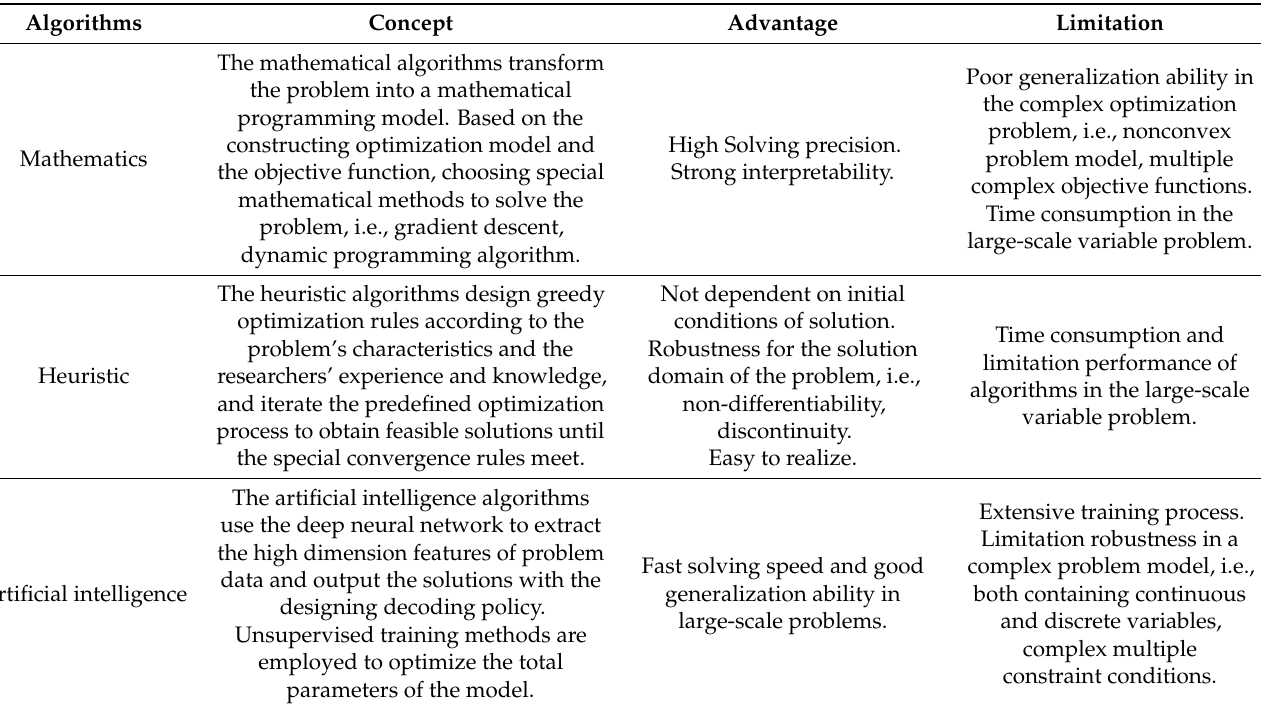
Table 1. The common optimization algorithms for UAV mission